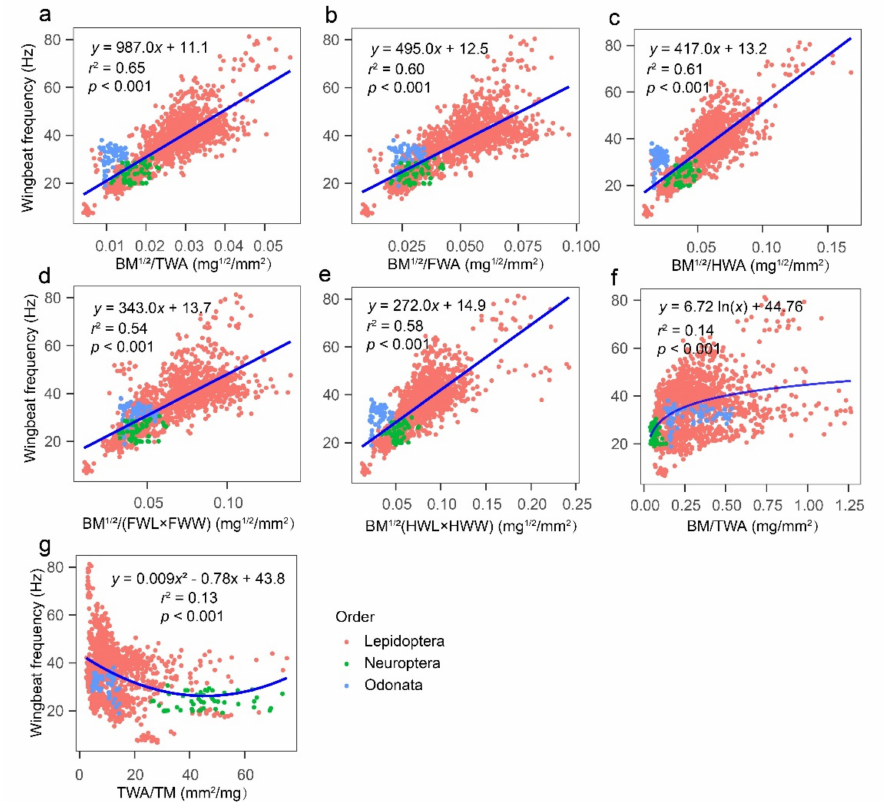
Figure 5. Regression models for wingbeat frequency and morphological variables ( a ) the square root of body mass divided total wing area, ( b ) the square root of body mass divided forewing area, ( c ) the square root of body mass divided hindwing area, ( d ) the square root of body mass divided by the product of forewing length and forewing width, ( e ) the square root of body mass divided the product of hindwing length and hindwing width, ( f ) body mass divided total wing area, and ( g ) total wing area divided by thoracic mass, for all tested insects. BM, body mass; TM, BM 1/2 , the square root of body mass; thoracic mass; AM, abdominal mass; BL, body length; BW, body width; FWL, forewing length; FWW, forewing width; HWL, hindwing length; HWW, hindwing width; FWA, forewing area; HWA, hindwing area; and TWA, total wing area. N = 1458